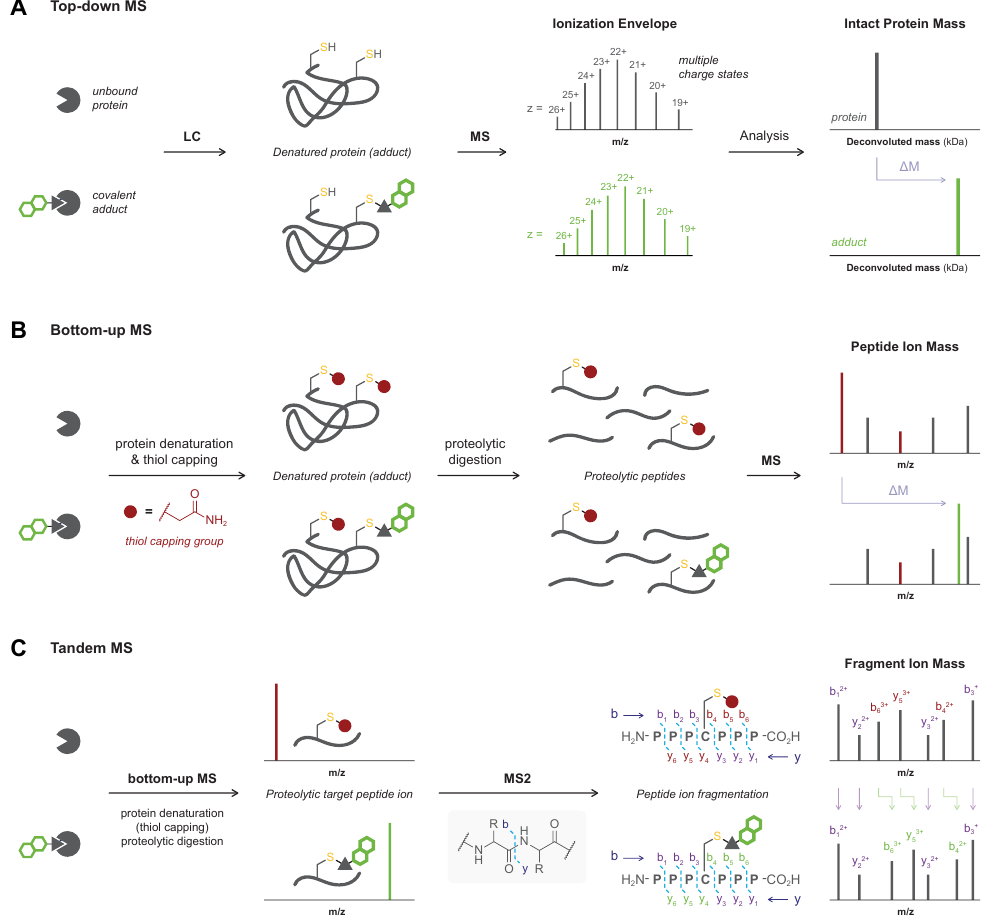
Figure 2. Schematic overview of MS-based methodologies for detection of covalent protein–drug adducts. ( A ) Intact protein analysis by top-down MS analysis. Samples containing unbound protein (top) or covalent adduct (bottom) are resolved by liquid chromatography (LC) to promote ligand dissociation in noncovalent complexes and remove free ligand. Intact protein and covalent adduct are subjected to MS analysis, where they are ionized multiple times (z ≥ 1) generating an ionization envelope originating from the various charge states, from which the deconvoluted total mass is calculated. The covalent protein–drug adduct has a higher deconvoluted mass than the unbound protein. ( B ) Bottom-up MS analysis. Samples containing unbound protein (top) or covalent adduct (bottom) are subjected to proteolytic digestion, with optional capping of free thiols using thiol-reactive reagent iodoacetamide (IAc) before or after digestion, followed by MS analysis. Proteolytic peptide ions originating from unmodified protein sequences are identical in both samples, whereas different mass is observed for peptide ions containing the covalently modified amino acid residue. ( C ) Tandem MS or MS/MS. Following bottom-up MS analysis, proteolytic peptide ions (MS1) are exposed to fragmentation conditions that break the amide bonds, producing one out of two possible fragment ions for each broken peptide bond. The resulting fragment ions are annotated with increasing numbers from the N-terminus (b-fragment ions) or C-terminus (y-fragment ions). A mass difference is observed for fragment ions (MS2) containing the modified amino acid, thereby aiding identification of the modified amino acid